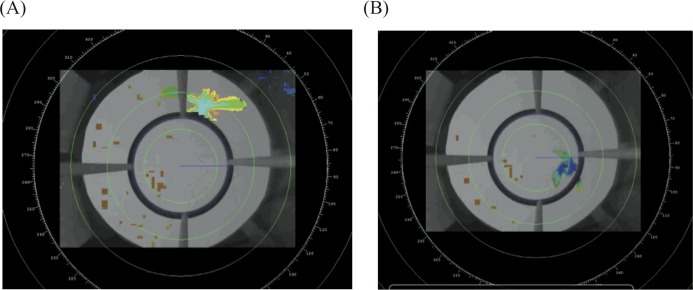
Example of the radR interface.The image shows two frames from a video taken from the bottom center of the cage. The perch exclusion zone is the area within the circular perch.